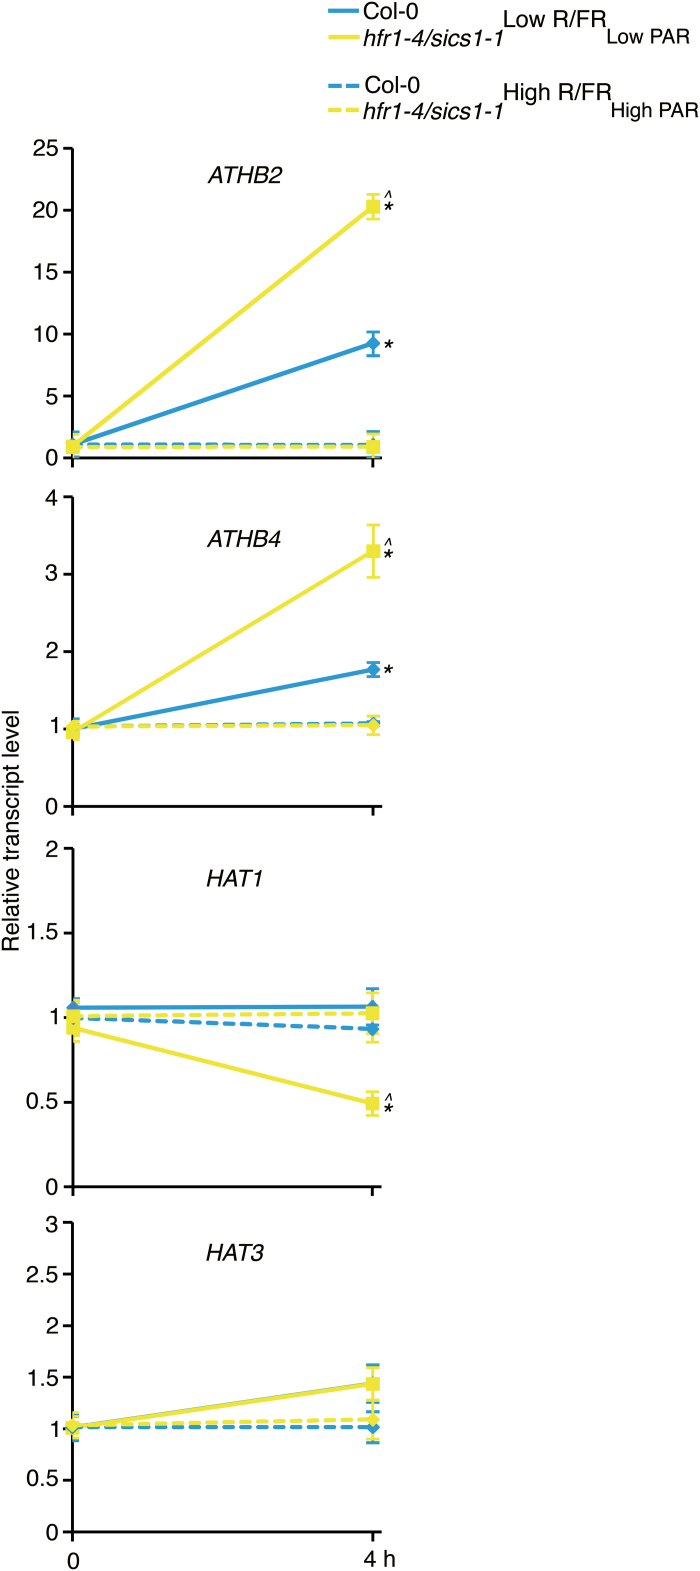
The HD-Zip II ATHB4 gene is up-regulated in hfr1/sics1 mutant seedlings in shade. RT-qPCR analyses of ATHB2, ATHB4, HAT1, and HAT3 in Col-0 and hfr1-4/sics1-1. Plants were grown for 7 d in a light/dark cycle (16/8 h) in High R/FRHigh PAR, and then either maintained in High R/FRHigh PAR (High R/FRHigh PAR) or transferred to Low R/FRLow PAR (Low R/FRLow PAR) under the same regimen for 4 h. Plant transfer to Low R/FRLow PAR was performed 4 h after the beginning of the light period. The graphs show the relative expression levels in High R/FRHigh PAR and Low R/FRLow PAR of ATHB2, ATHB4, HAT1, and HAT3 in the two genotypes. Each value is the mean of three biological replicates normalized to EF1α expression (±SD). Statistical significance was assessed by means of one-way ANOVA followed by Tukey’s test. *P<0.001 Col Low R/FRLow PAR and hfr1-4/sics1-1 Low R/FRLow PAR versus Col-0 High R/FRHigh PAR; ^P<0.001 hfr1-4/sics1-1 Low R/FRLow PAR versus Col-0 Low R/FRLow PAR.